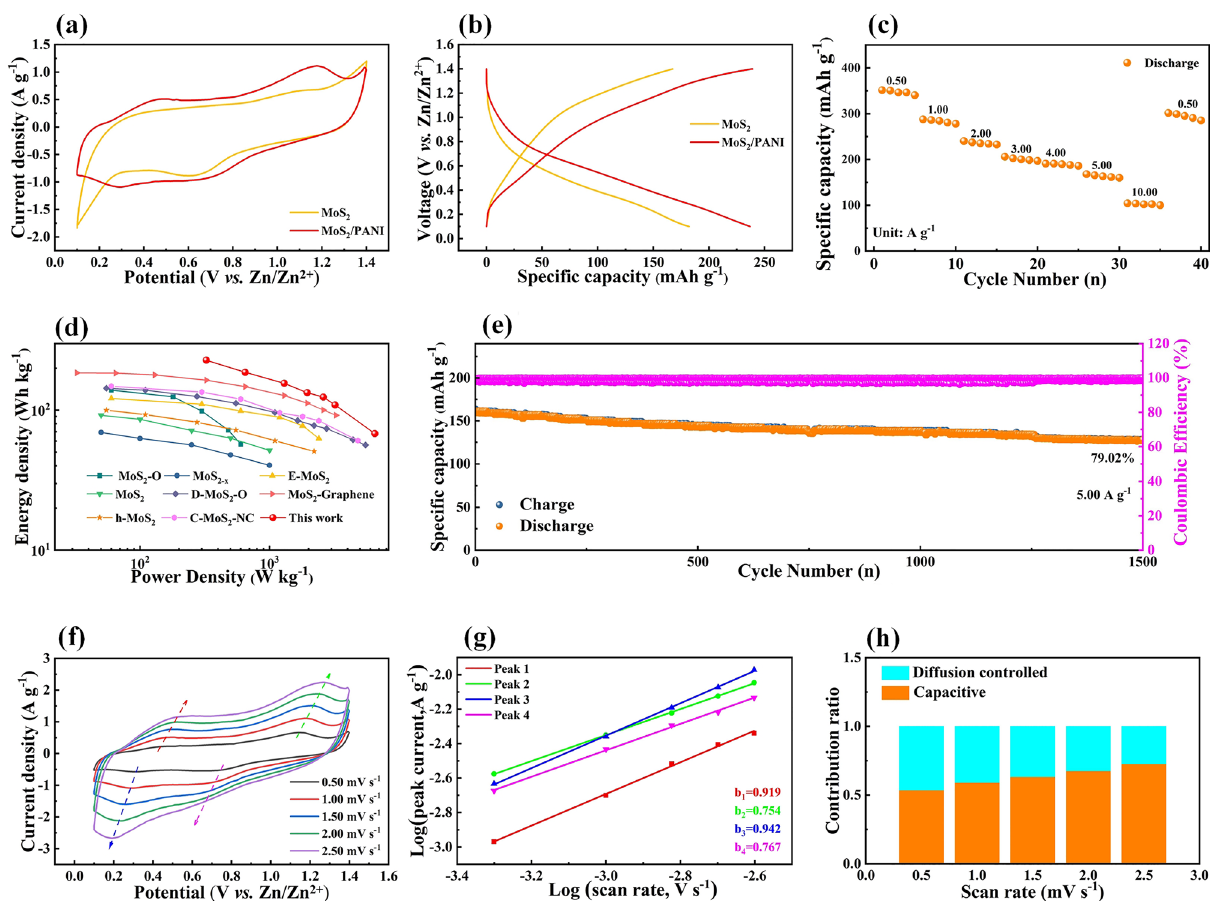
Fig. 2 Electrochemical performances and electrode process kinetic of MoS 2 /PANI cathodes in air. a CV curves at a scan rate of 1.0 mV s −1 and b GCD curves at a current density of 2.0 A g −1 of the MoS 2 /PANI cathodes and MoS 2 cathodes. c Rate capability, d energy and power density plot, e cyclic life and Coulomb efficiency and f CV curves at different scan rates from 0.50 to 2.50 mV s −1 of the MoS 2 /PANI cathodes. g Log (i) versus log (v) plots and h contribution ratios of diffusion-controlled and capacitive capacities at different scan rates of the MoS 2 /PANI